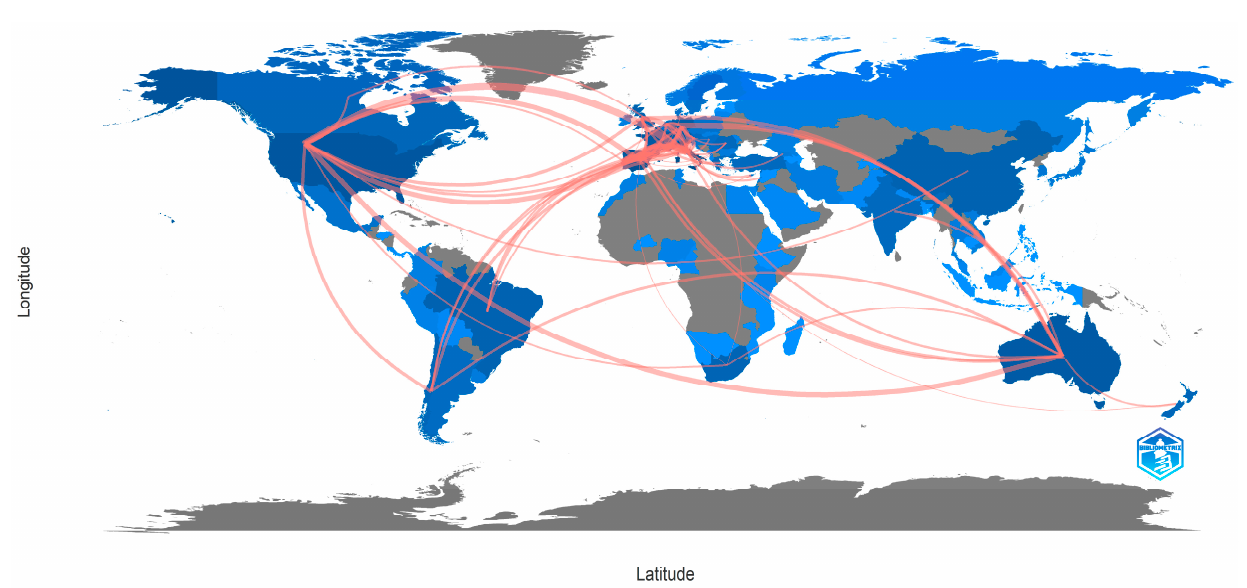
Figure 8. Collaboration world map .